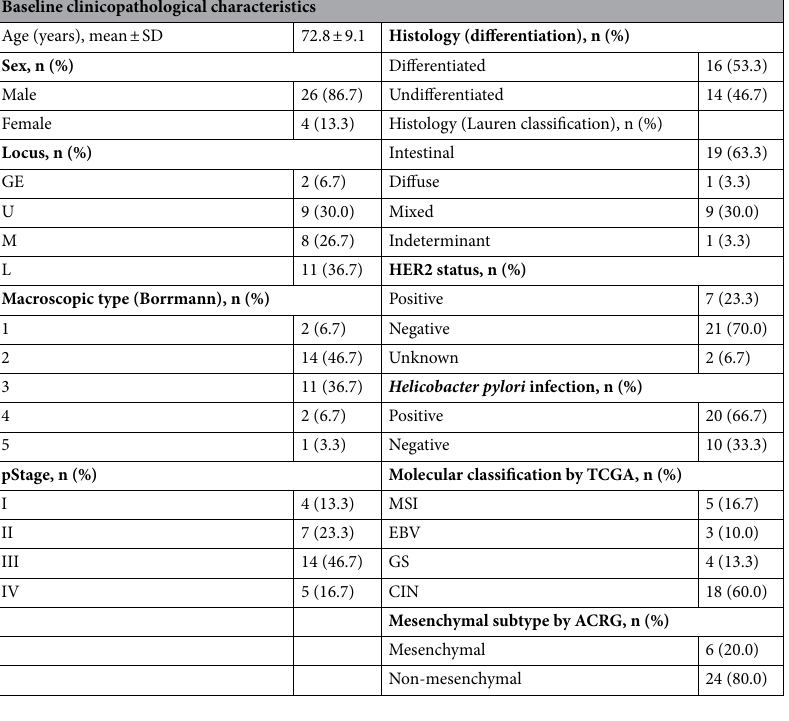
Table 1. Characteristics of individual